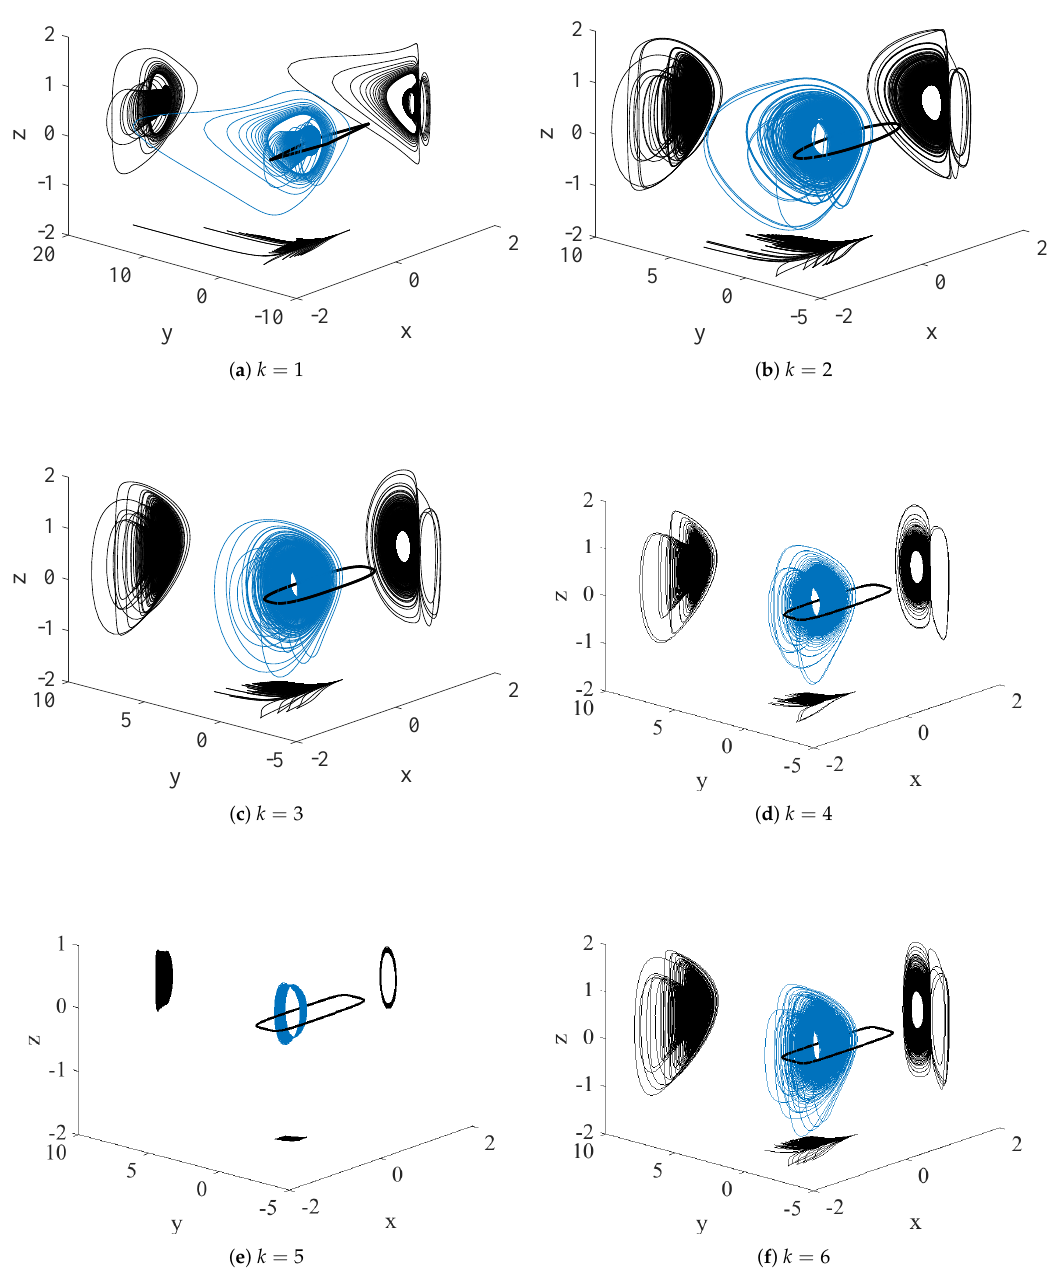
Figure 2. 3D perspective view and plane projections of systems for k from 1 to